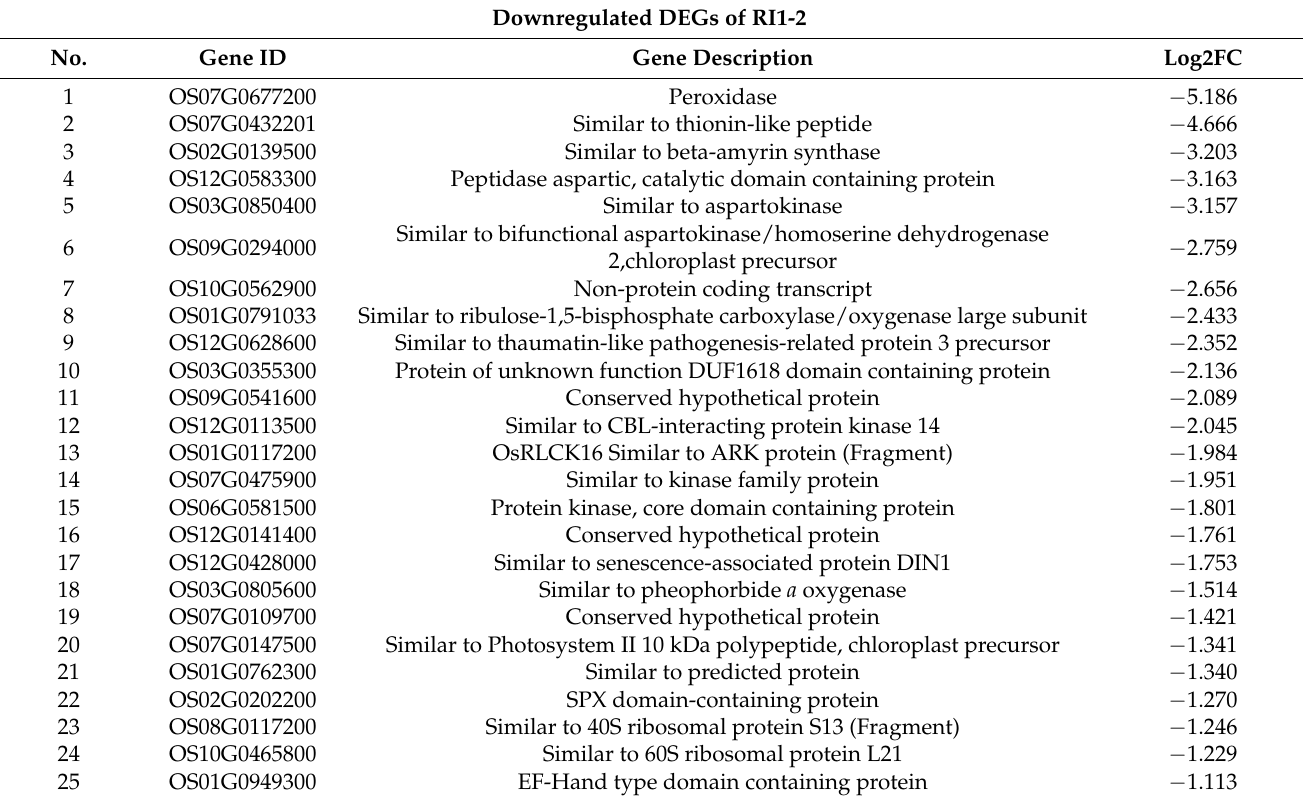
Table 2. Downregulated differentially expressed genes in RI1-2 and RI1-3 as ranked by log2FC value. Downregulated DEGs of